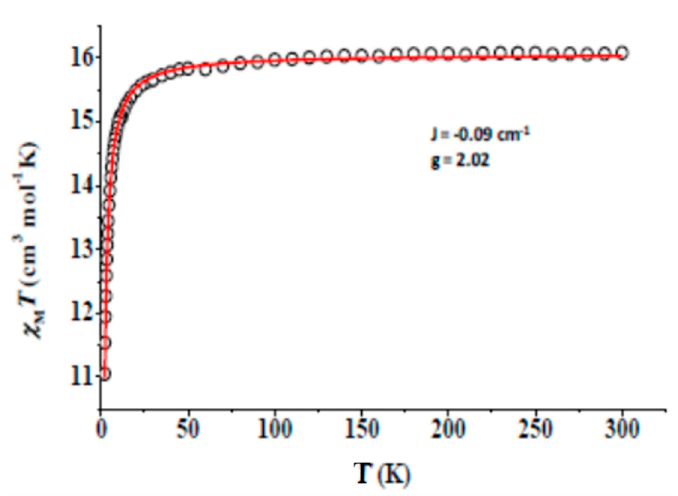
Figure 10. Temperature dependence of the χ M T product of complex 3 at 0.1 T. The solid red line is the fit of the data to the theoretical Heisenberg model for a Gd III 2 complex; see the text for details.